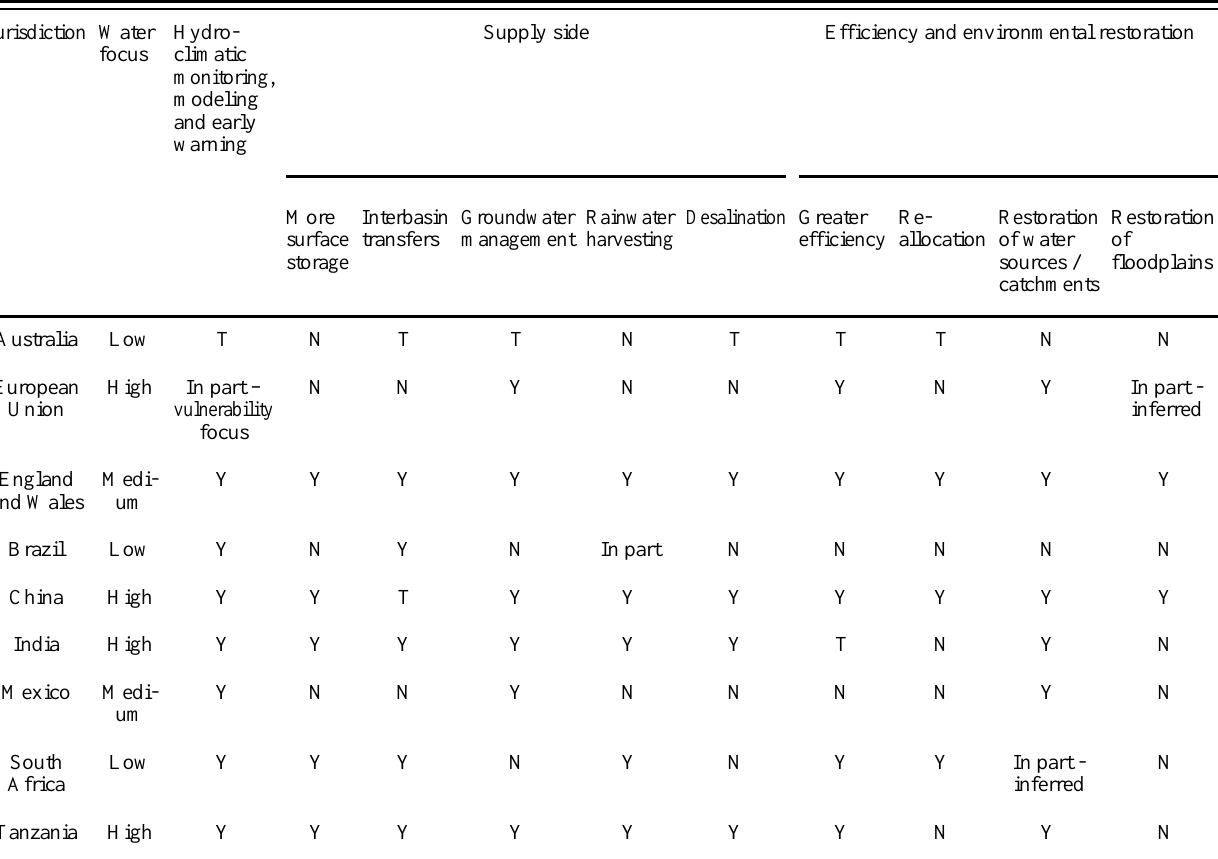
Table 3. Climate adaptation policy and water related